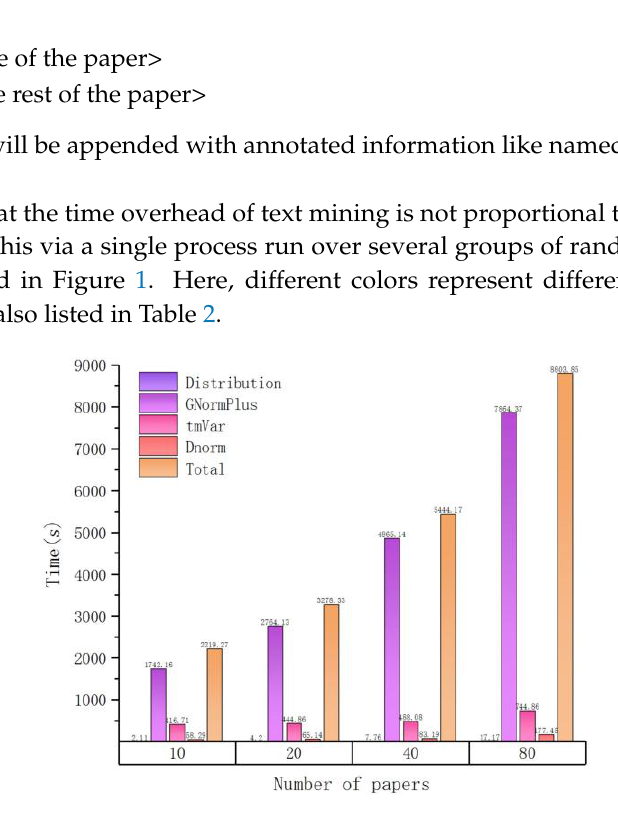
Figure 1. The time cost of processing different numbers of input articles in serial. Table 2. Time distribution of processing different numbers of input articles in serial.